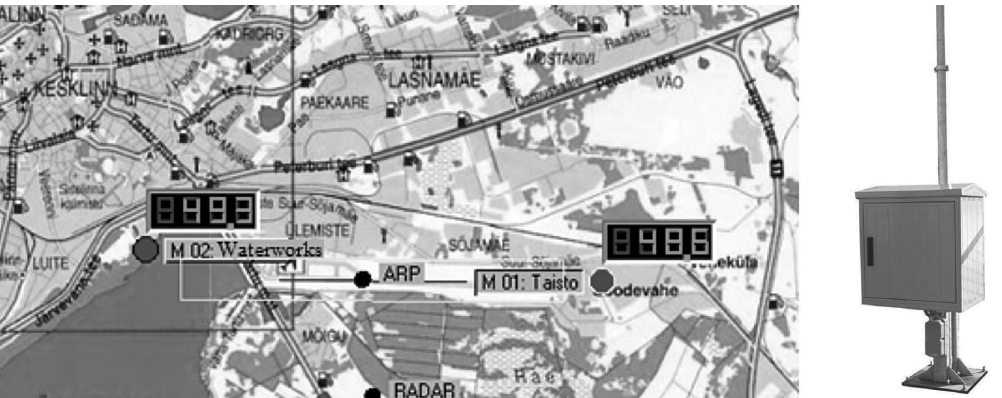
Fig. 1. Noise monitoring station (right) and their locations (left). (Keskküla 2012b)